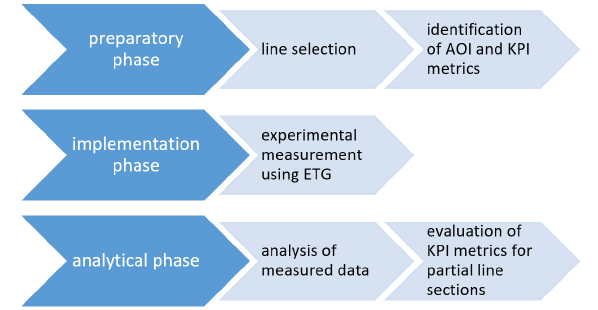
Figure 4: Methodology of